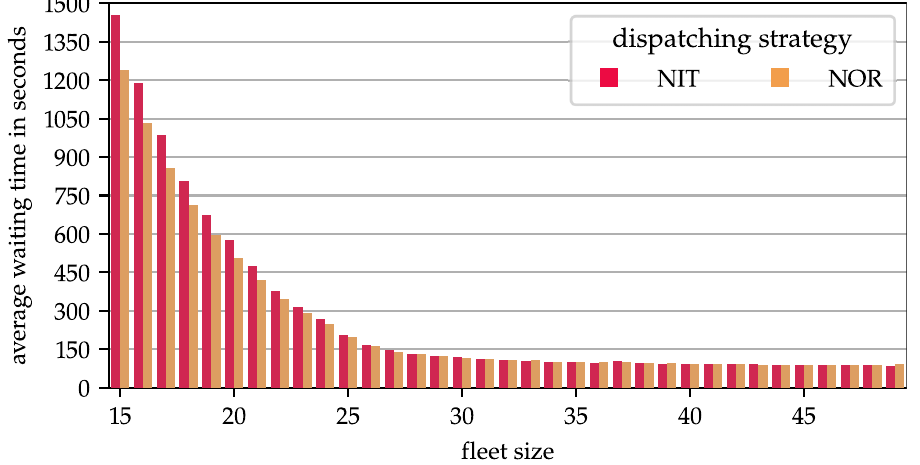
Figure 8. Comparison of dispatching strategies NIT and NOR regarding average waiting time for different